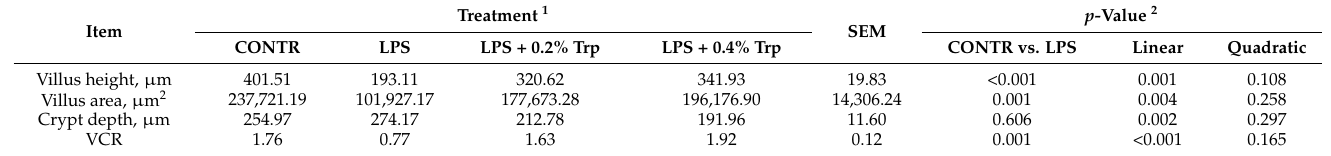
Table 3. Effect of tryptophan supplementation on ileal morphology after 4 h LPS challenge in piglets.